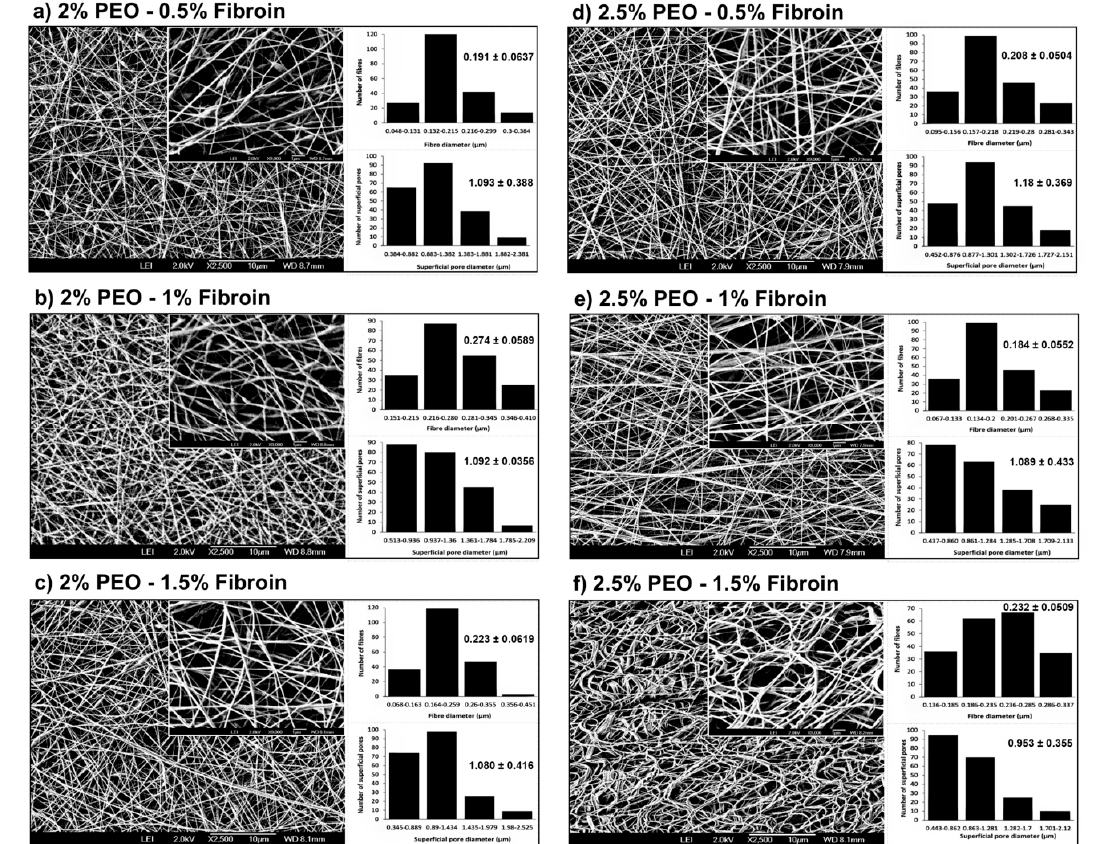
Figure 2. SEM micrographs of electrospun fibers, bar graphs of the fiber diameter ( µ m), and the superficial pore diameter ( µ m) at ( a ) 2% PEO–0.5% fibroin, ( b ) 2% PEO–1% fibroin, ( c ) 2% PEO–1.5% fibroin, ( d ) 2.5% PEO–0.5% fibroin, ( e ) 2.5% PEO–1% fibroin, and ( f ) 2.5% PEO–1.5% fibroin